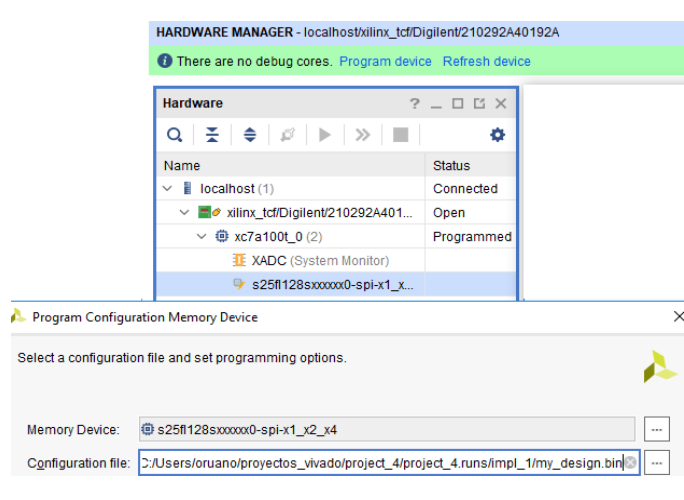
Sensors 2021 , 21 , x FOR PEER REVIEW Figure 20. File generation for flash memory (.bin). Figure 20. File generation for flash memory (.bin).